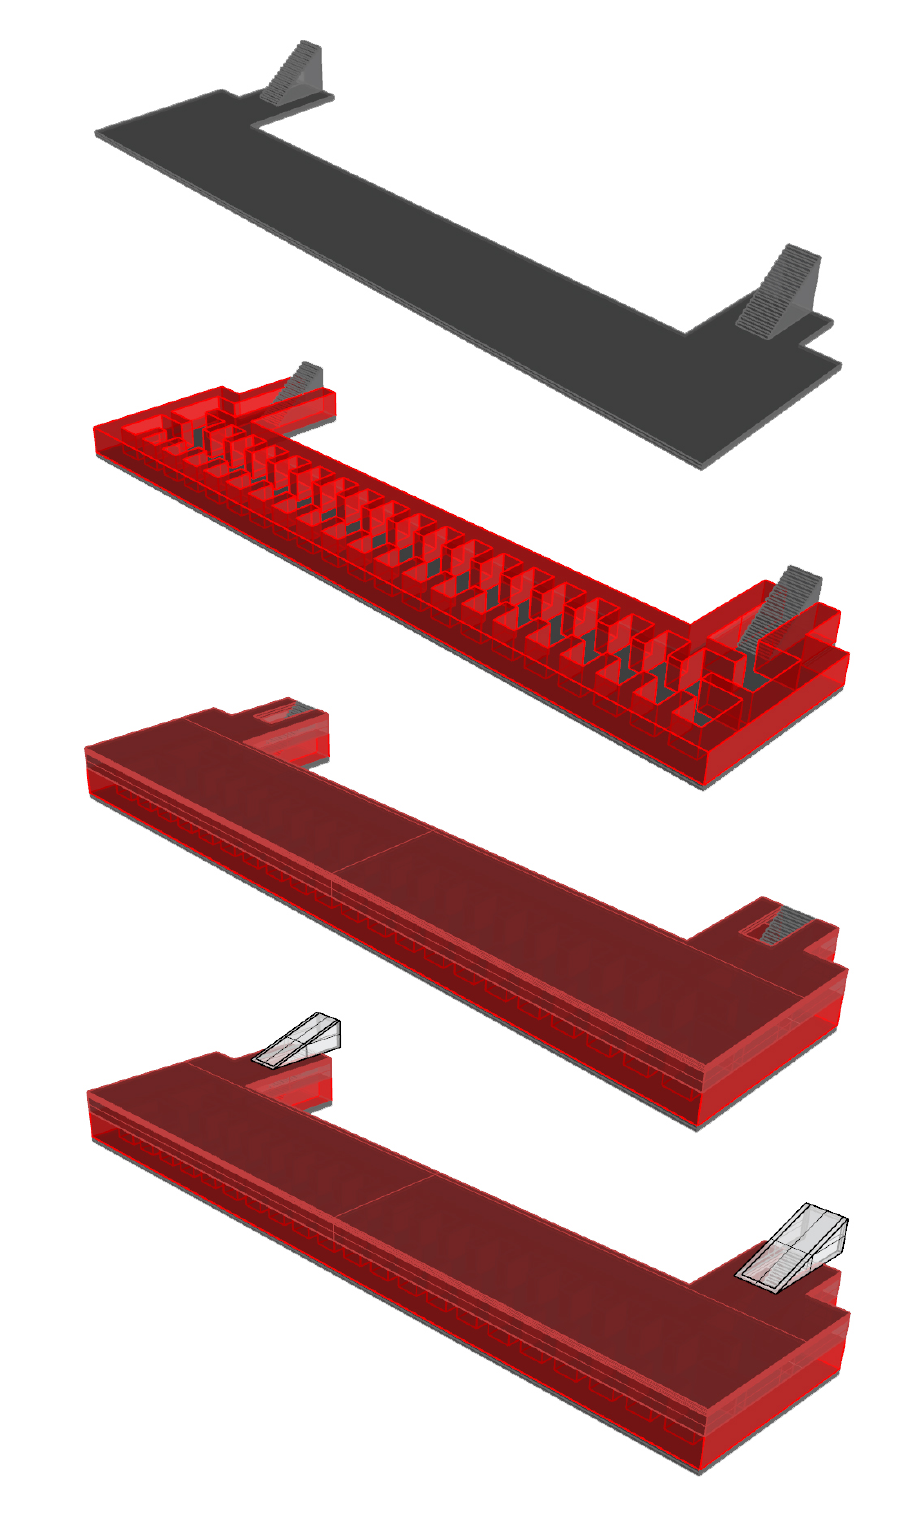
Figure 2. Image of the 3d reconstruction of the entire volume of the